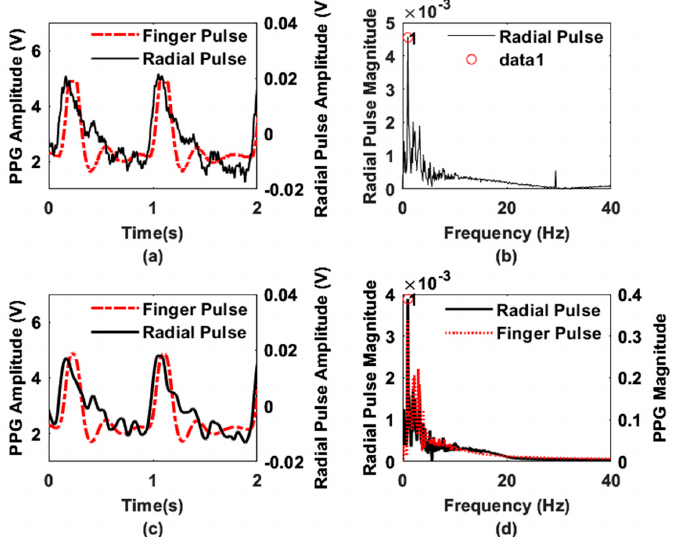
Figure 7 . Demodulated waveform obtained for 36 MHz RF carrier during pulsatile blood flow at the radial location of a human subject. Here, ( a ) raw (original) and ( c ) filtered time domain signals and ( b ) and ( d ) the frequency spectrum of the raw and filtered signals, respectively. In ( b ) data 1 represents the peak of the maximum amplitude. The resonator and PPG sensor’s data show that the most prominent frequencies (peak 1 in Figure 7d) are overlapped at 1 Hz. The time domain waveforms from the two different sensing modalities, i.e., optical and the proposed electromagnetic sensor, also exhibit characteristic peaks and notches, which are the consequences of flow separation (backflows) due to arterial resistance variations in the vasculatures [37]. Since the wave ‐ forms were obtained at two locations (wrist (radial artery) and finger), the flow resistance could vary accordingly due to different path resistances [37]. As a result, the waveforms will have amplitude and phase differences, i.e., leading and lagging behavior. However, the morphological characteristics, i.e., the presence of peaks and notches, are driven by the same physiological phenomena of the systolic upstroke, systolic peak, dicrotic notch, and diastolic downstroke. It is also evident that the modulation in the resonator’s response is solely due to the periodicity of the radial pulse, excluding any external movement arti ‐ fact from the subjects’ bodies. Note that, during data collection, the presence of any exter ‐ nal body movement was isolated to ensure the fidelity of the acquired signals. In Figure 7b, the signal ‐ to ‐ noise ratio (SNR) can be determined by defining the noise floor and signal amplitude [35]. Based on our observations between Figure 7b,d, we set the noise floor based on the amplitude of the peak observed at 29.36 MHz (resulting from the RF carrier leakage in the demodulator) and the signal level to the maximum amplitude of the peak (data ‐ 1 in Figure 7b) observed at 1 Hz. Based on the amplitude information, the calculated SNR value is 18.18 dB. Figure 8 shows the effect of different pass bands on the radial pulse waveform. Filter 1 (passband frequency of 0.25 to 7.5 Hz) attenuates the signal more highly than other fil ‐ ters, whereas filter 4 (passband frequency of 0.25 Hz to 37.5 Hz) includes noise compo ‐ nents, as confirmed by Figure 7b. The waveform responses for different low ‐ pass cutoff